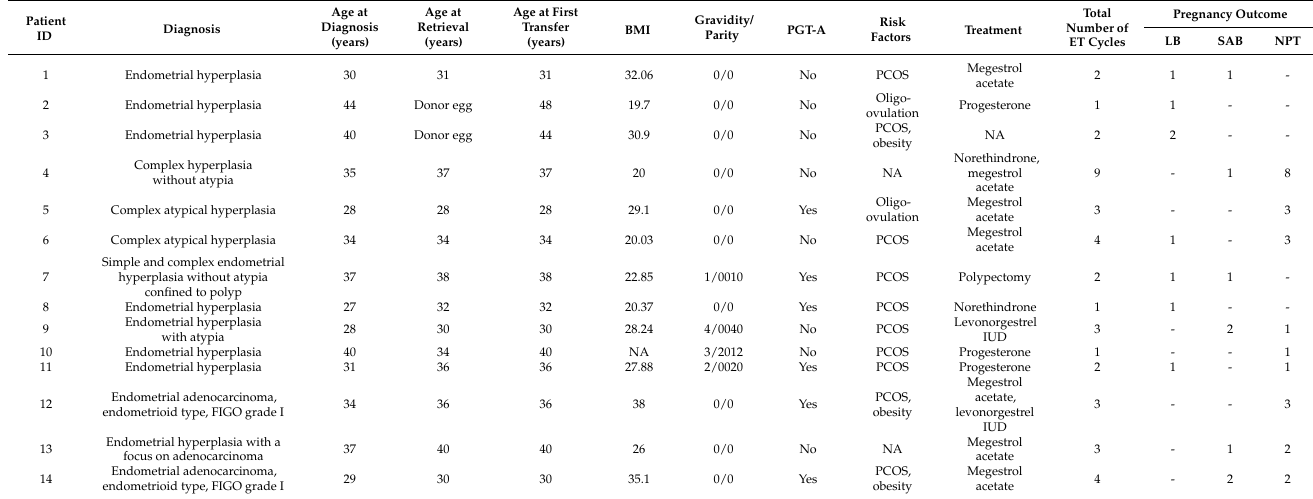
Table 2. Individual characteristics of patients with EMCA/EH after FST presenting for embryo transfer.